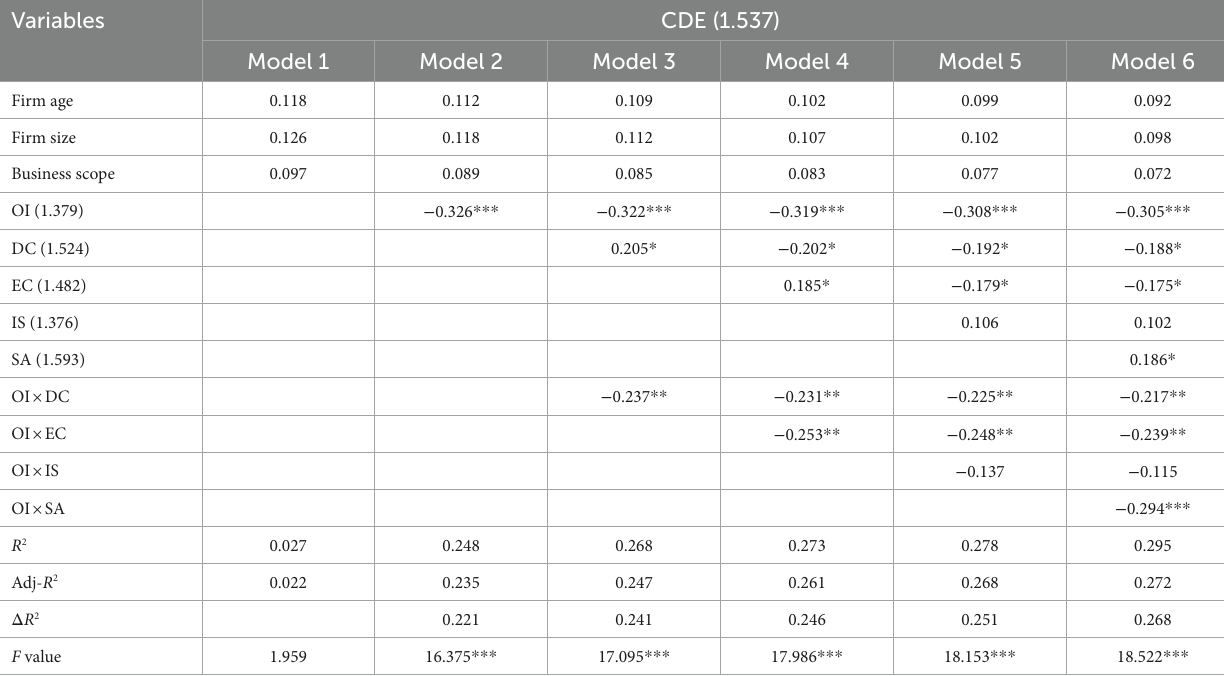
TABLE 4 The results of regression analysis of main